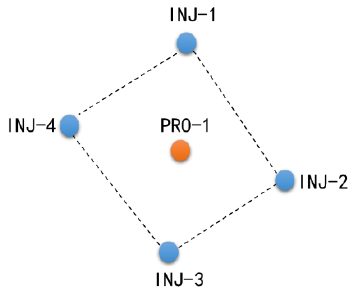
Figure 3. Bitmap of well group to be selected.